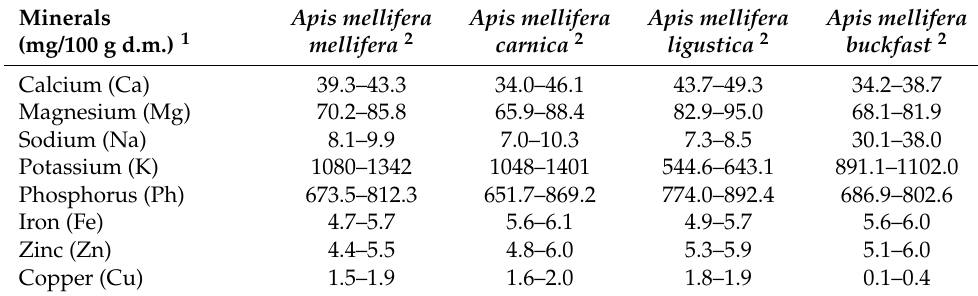
Table 6. Minerals of drone pupae of Apis mellifera subspecies [38].